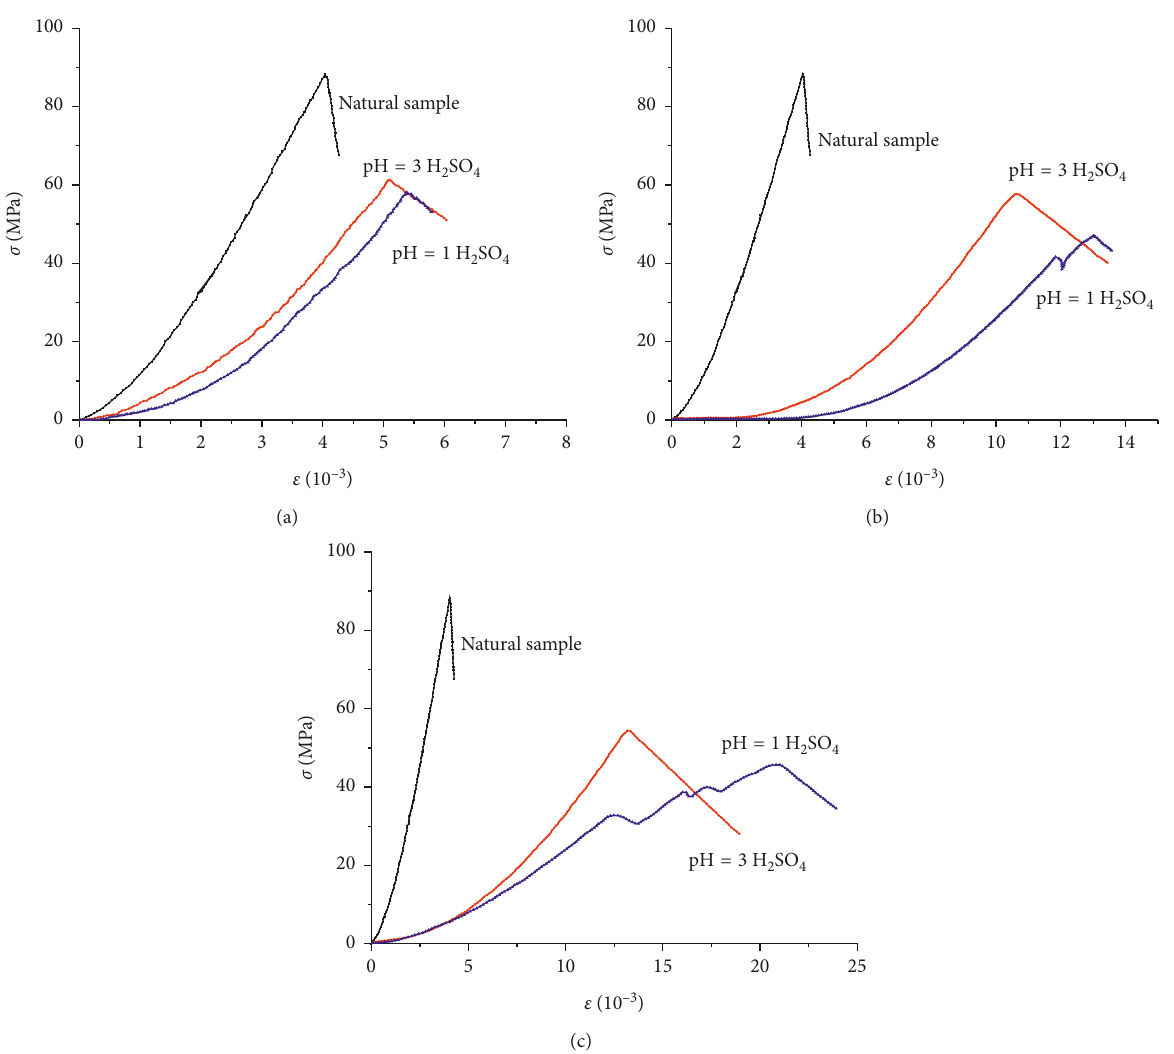
Figure 8: Uniaxial compressive stress-strain curves for the sandstone samples attacked by acid solutions for different soaking days: (a) 30 days, (b) 90 days, and (c) 180